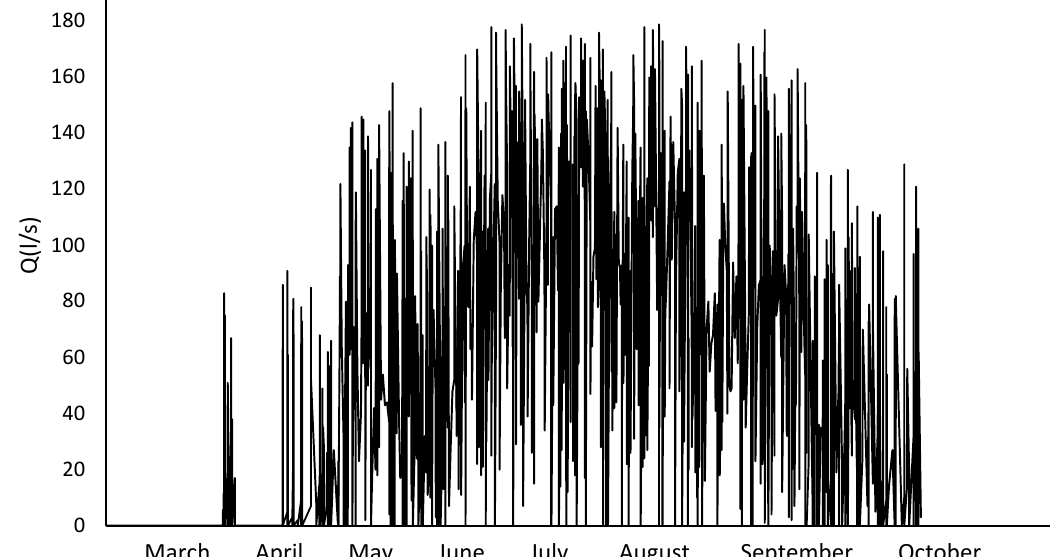
Figure 7. Experimental flow distribution during the irrigation season for EPP 3.